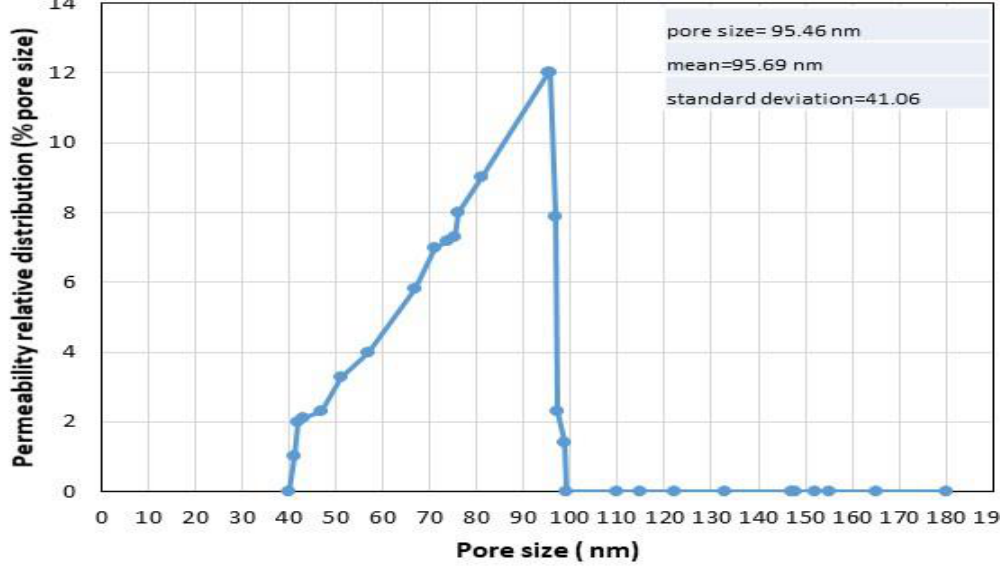
Figure 4. The pore size distribution of the fabricated membrane.